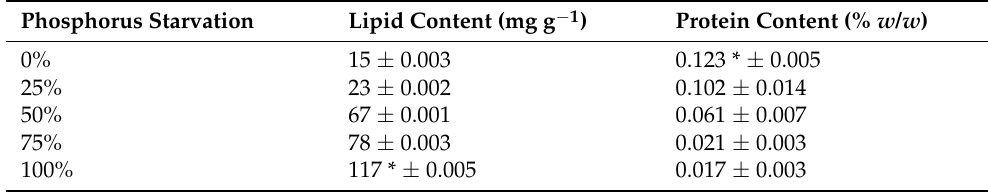
Table 1. Lipid and protein content of C. vulgaris after seven days growth at different phosphorus